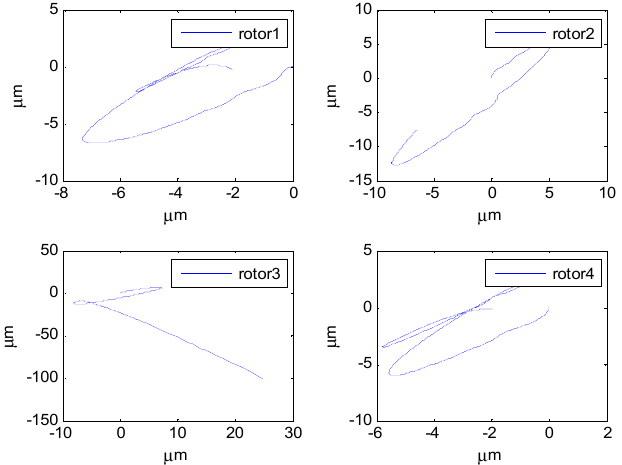
Figure 25. The rotor X-Y displacement without feedforward